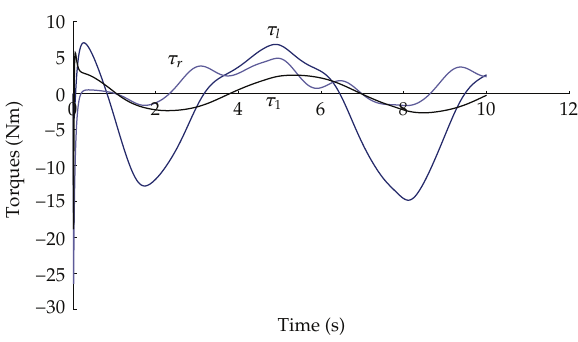
Figure 4: The torques of the joints.